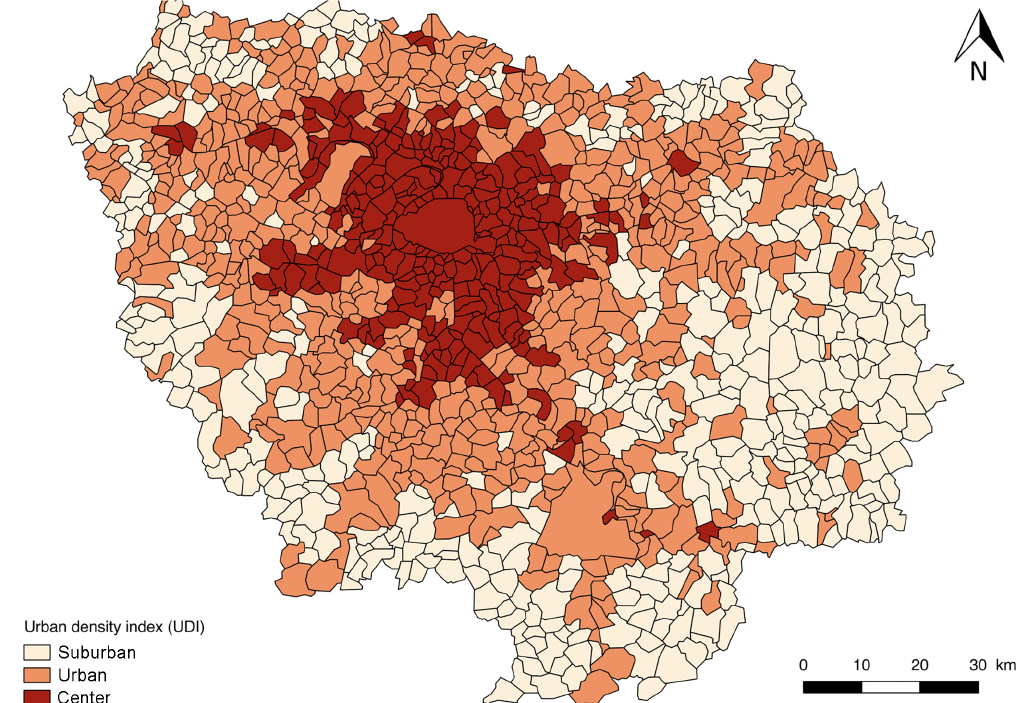
Figure 11. TAZ subdivision and urban density index (UDI) of greater